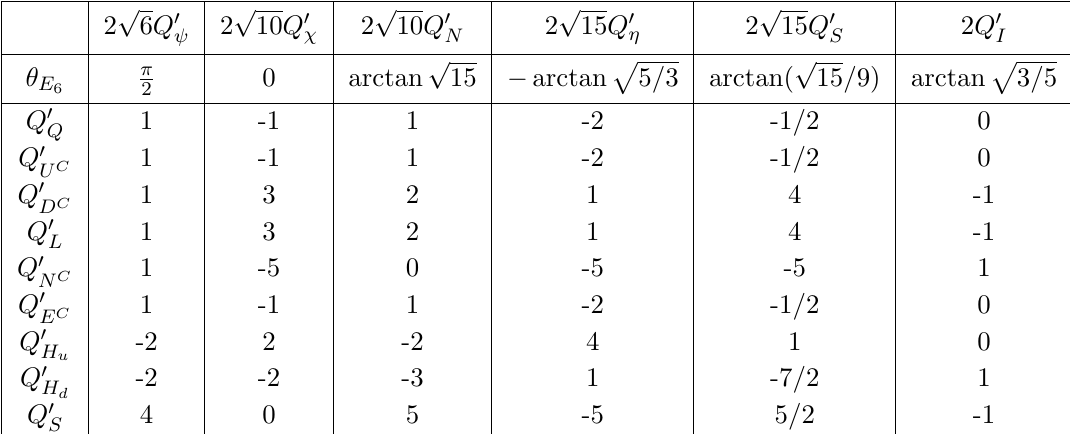
Table 1. U(1) 0 charges of the chiral super(cid:12)elds contained in the UMSSM, for certain values of (cid:18) E 6 .